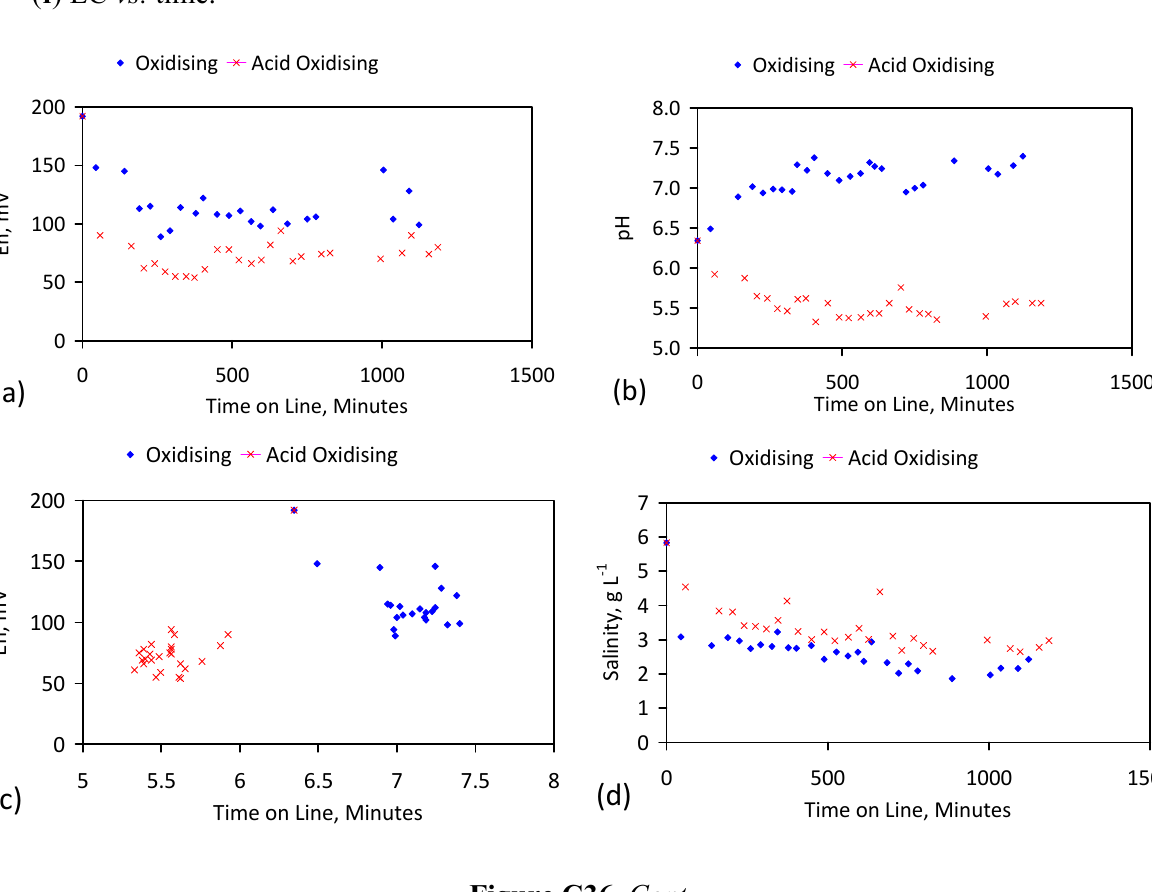
Figure C35. ZVM TPA example Trial E146. 15th Reuse; Operating Temperature: 16–20 °C; Oxidising Environment: Water volume in the reactor = 0.24 m 3 ; ZVM TPA from Trial E145 in a cartridge = 0.4 kg; Air flow = 120 L·h − 1 . Acid Oxidising Environment: Water volume in the reactor = 5.4 L; ZVM TPA from Trial E144 in a cartridge = 0.4 L; Gas flow (80% N 2 + 20% CO 2 ) = 3.3 L·h − 1 . ( a ) Eh vs. time; ( b ) pH vs. time; ( c ) pH vs. Eh; ( d ) Salinity vs. time; ( e ) Salinity calculated from normalised data vs. salinity calculated from raw data. ( f ) EC vs.